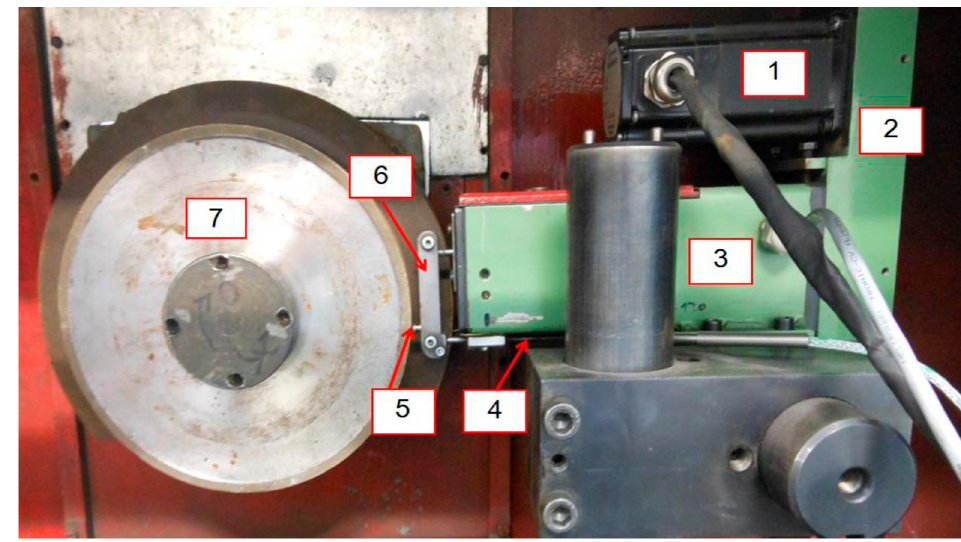
Figure 5. A measuring device for assessing the grinding ability of grinding wheels: 1—stepper motor, 2—toothed gear, 3—sample feed mechanism with a force sensor, 4—tester guide, 5—tester with thermocouple, 6—mounting clamp, 7—grinding wheel.